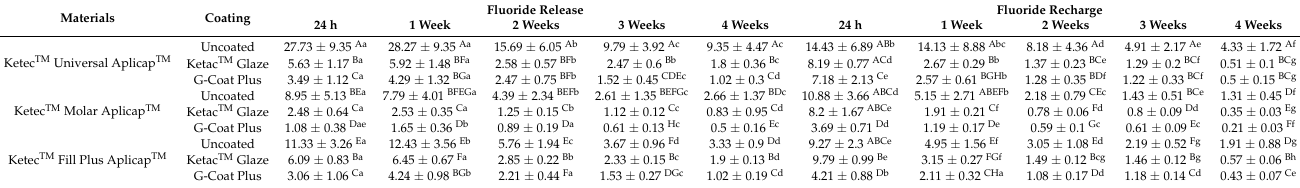
Table 2. Means ± standard deviation (SD) of the fluoride release and recharge of the tested